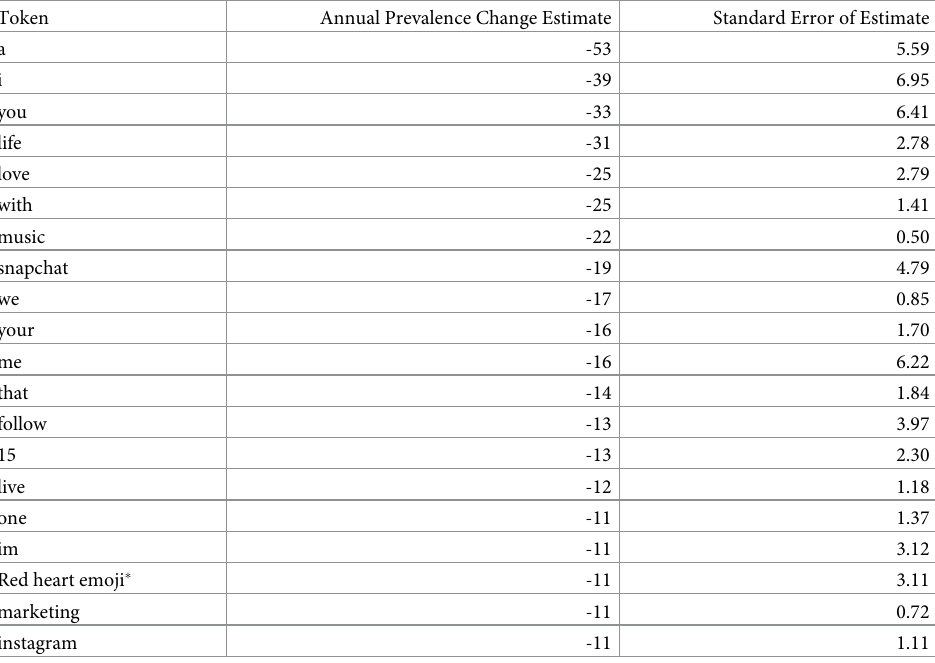
Table 7. Top 20 loser tokens in the cross-sectional